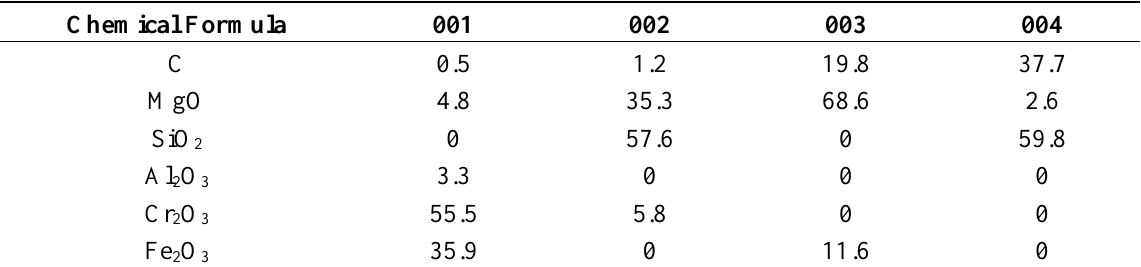
Figure 8. Backscattered scanning electron image of fully carbonated olivine and EPMA scanning of selected areas; mounted sample was coated with platinum and palladium for the analysis. Table 3. Chemical composition (%), determined by EPMA, of spot areas in Figure 8; carbon as elemental C and other elements as